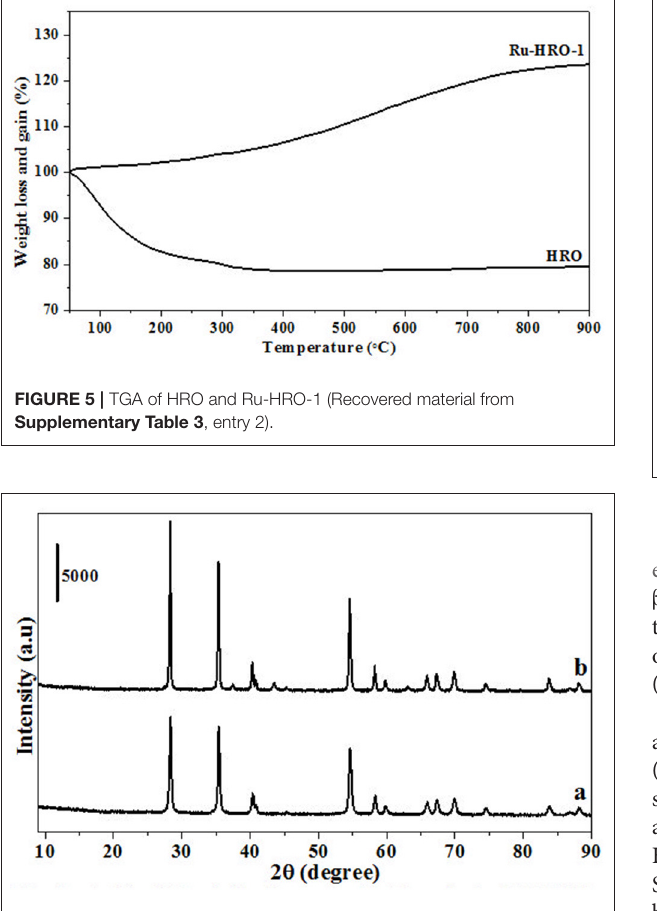
FIGURE 6 | PXRD of materials obtained after thermogravimetric analysis. (a) HRO (b) Ru-HRO-1.